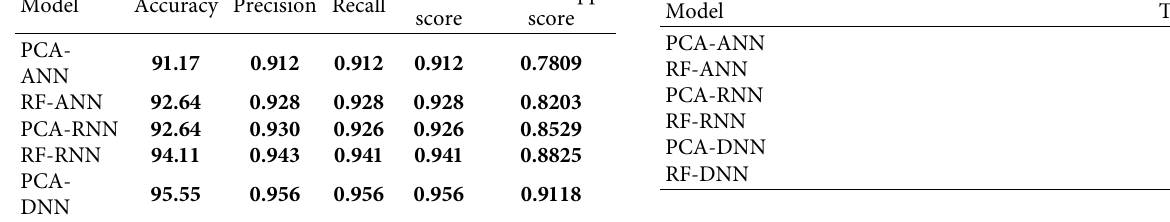
Table 2: Validation of the proposed model for 15features. Model